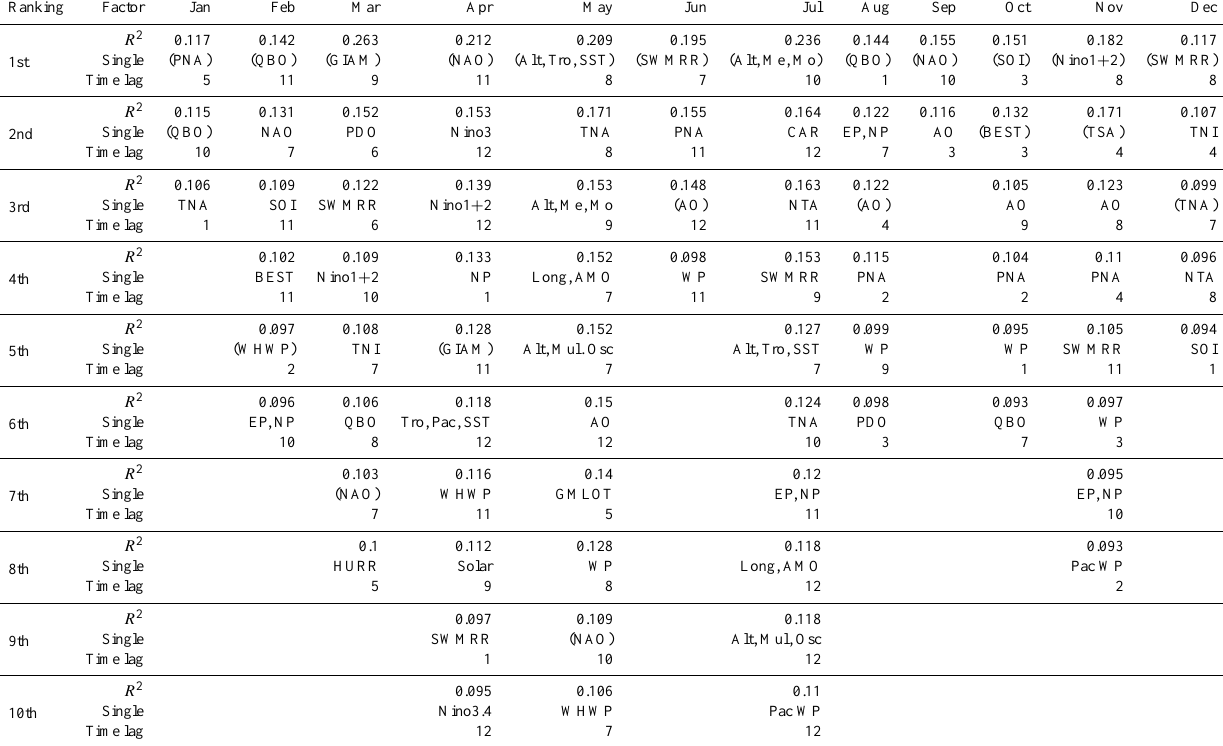
Table 3. Ranked indices and proper time lags for each month of a year. Ranking